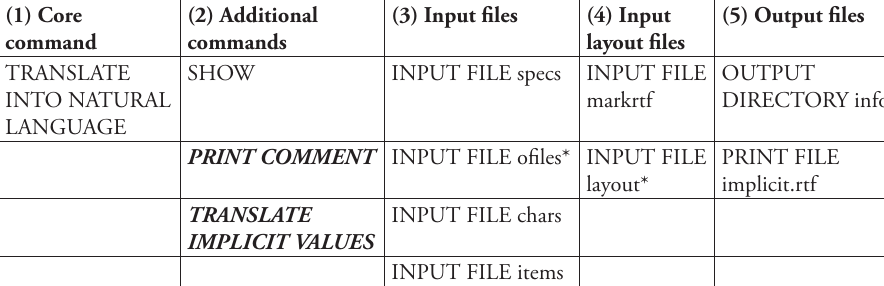
Table 5. Classifi cation of commands used in the tonatsr directive fi le. Reference numbers used in Fig. 32 are given in the header of the table. Th e commands in bold and italics may require changes being made by the user.